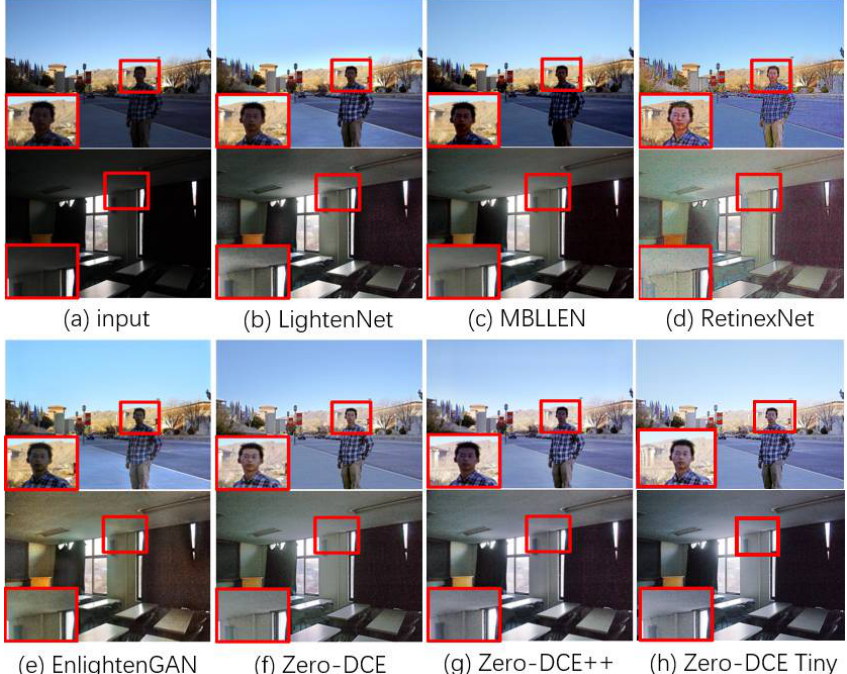
Figure 8. A visual comparison among the results generated by different methods. Subfigure ( a ) shows the original input, subfigure ( b – h ) respectively show the enhanced image results through LightenNet [26], MBLLEN [8], RetinexNet [9], EnlightenGAN [27], Zero-DCE [5], Zero-DCE++ [6] and Zero-DCE Tiny methods.